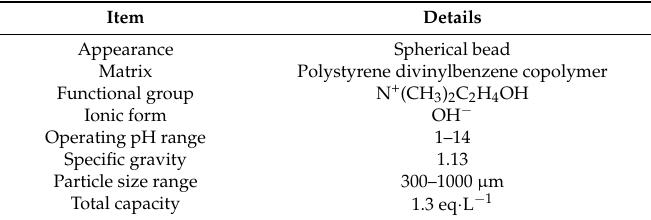
Figure 1. Structure of the anion exchange resin. Table 1. Properties of the anion exchange